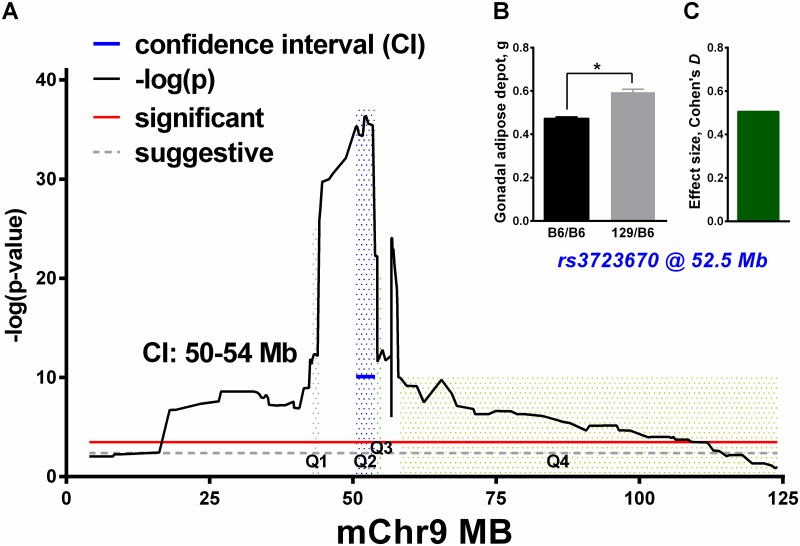
Detection of gonadal adipose depot weight QTLs on chromosome 9 by association analyses of a pooled congenic population.(A) Location of the markers in Mb on mouse chromosome 9 (mChr9); the y-axis is the—log p-values (black line) obtained in a general linear regression model analysis with body weight and strain as covariates (red line, significant threshold; gray line, suggestive). We defined the QTL confidence intervals by two units of—log10 p-value drop from the peak (blue line). For QTL1-QTL4 (Q1-Q4), the shaded peak areas correspond to QTL regions defined by the sequential method. (B and C) Average weight of the gonadal adipose depot by genotype (B6/B6, B6/129; B) and Cohen’s D effect size (C) of rs3723670, the most associated marker (i.e., the marker with the lowest p value). *p<0.0001, difference between genotypes.